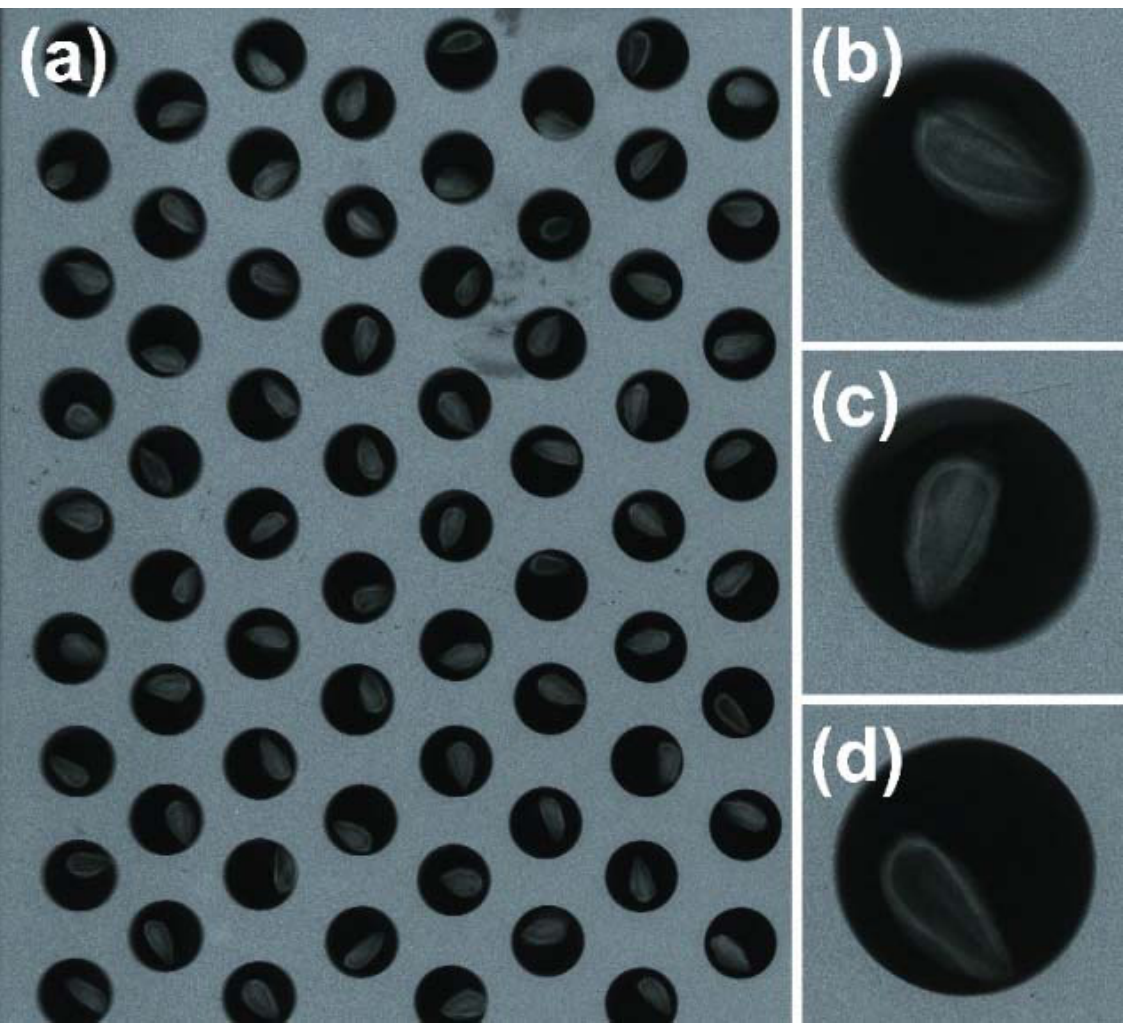
Figure 5. Juniperus communis L. dry seeds were analysed using the X ‐ ray method for assessing viability. ( a ) X ‐ ray film after analysis; ( b ) non ‐ viable seed, with not properly developed embryo; ( c ) viable seed, a properly developed embryo with undamaged seed coat; ( d ) empty seed, coat without embryo.